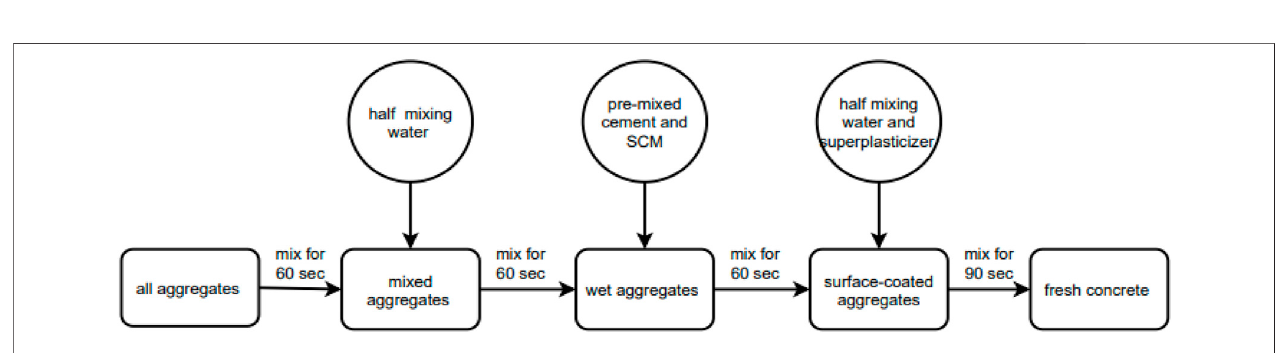
FIGURE 5 | Mixing procedure adapted from Tam and Tam